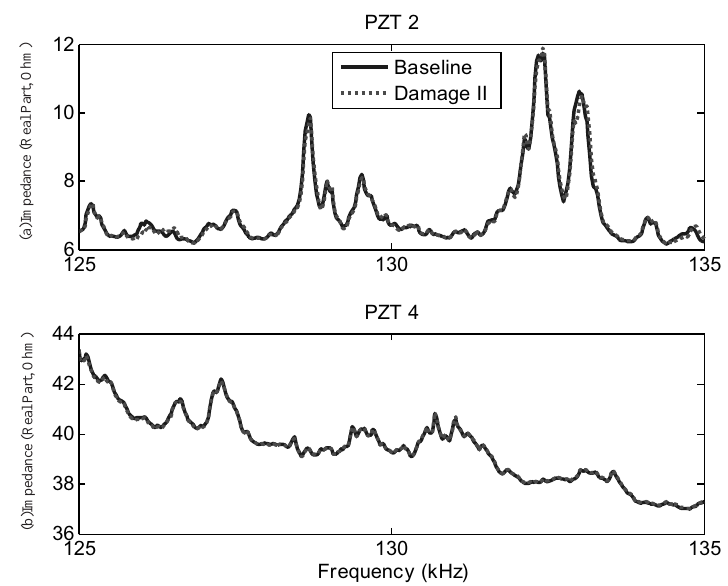
Fig. 6. Electrical Impedance measurement from PZT 2 and PZT 4 before and after Damage II.